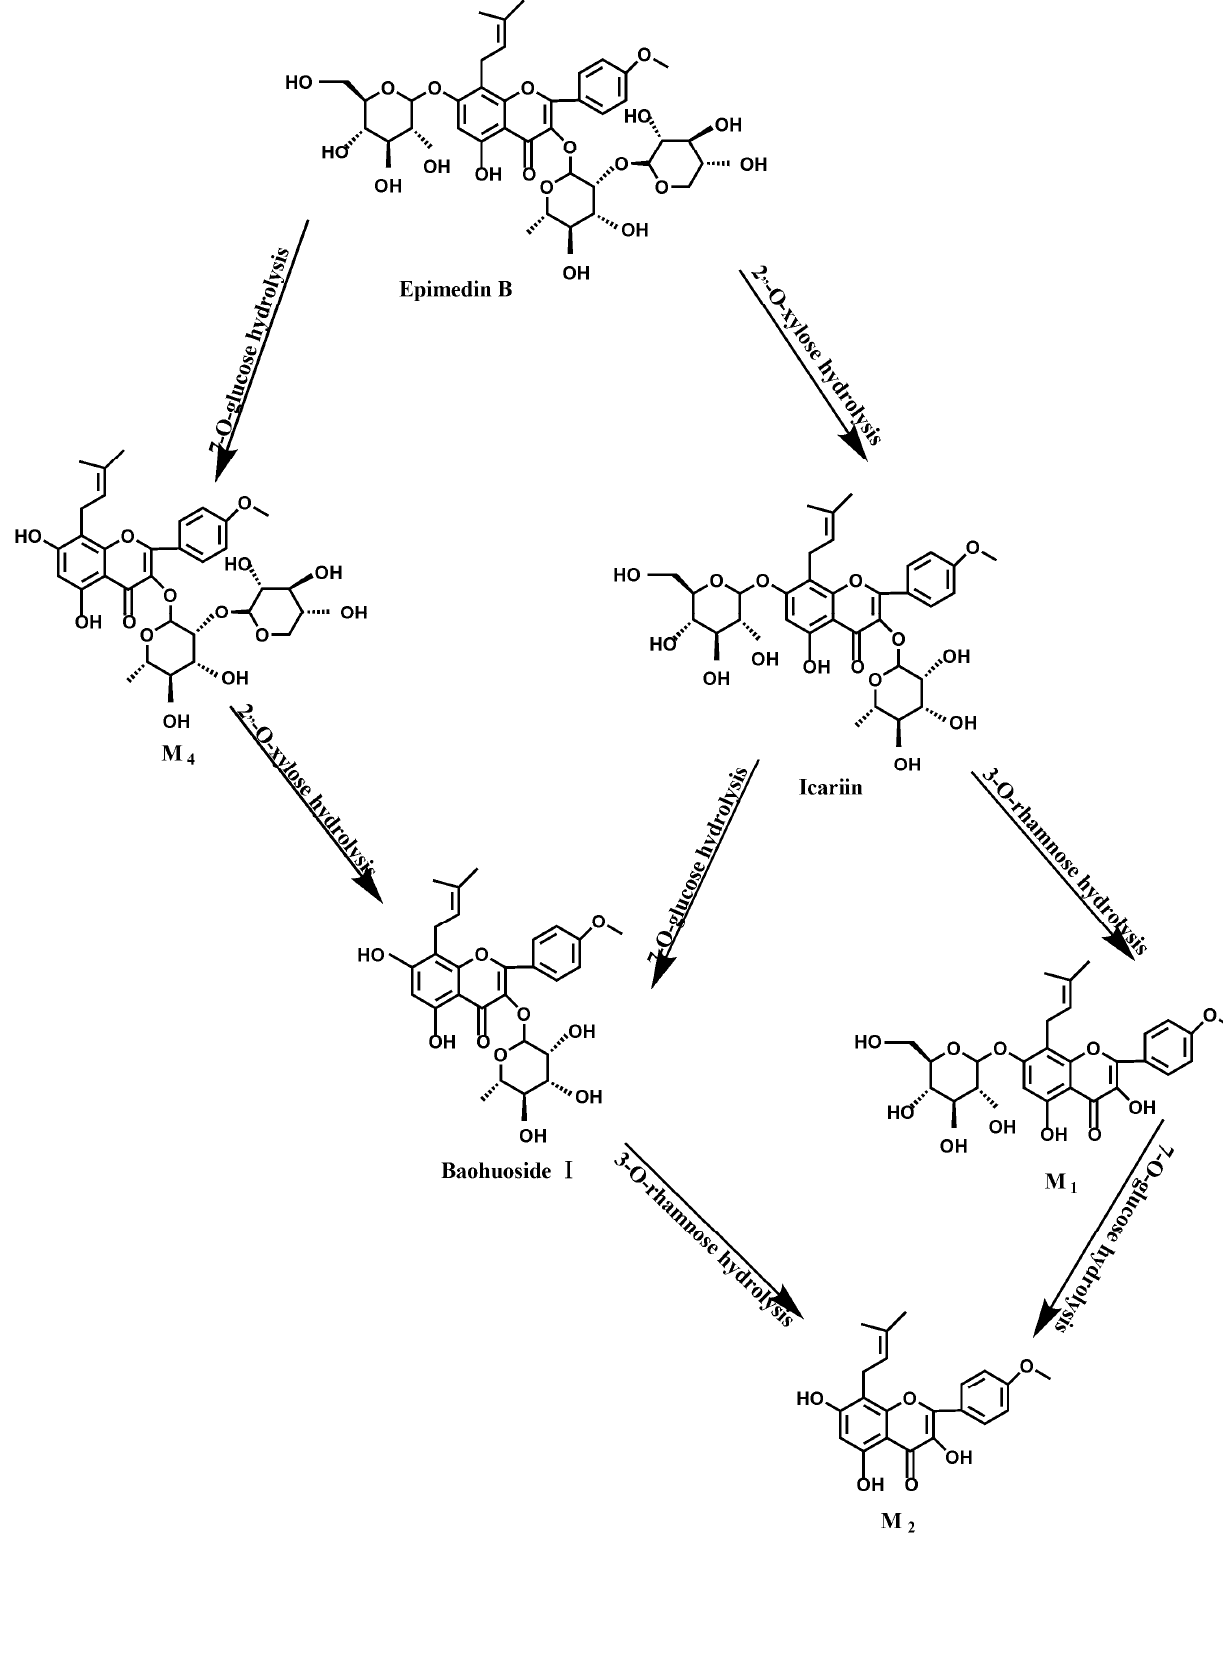
Figure 13. The metabolic pathway of epimedin B in intestinal flora and enzyme of